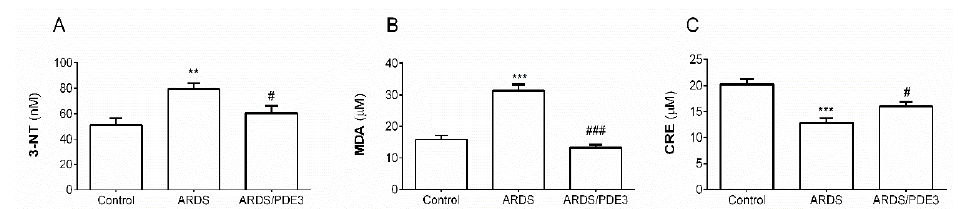
Figure 2. Levels of a marker of ( A ) oxidative modifications of proteins (expressed in nanomole